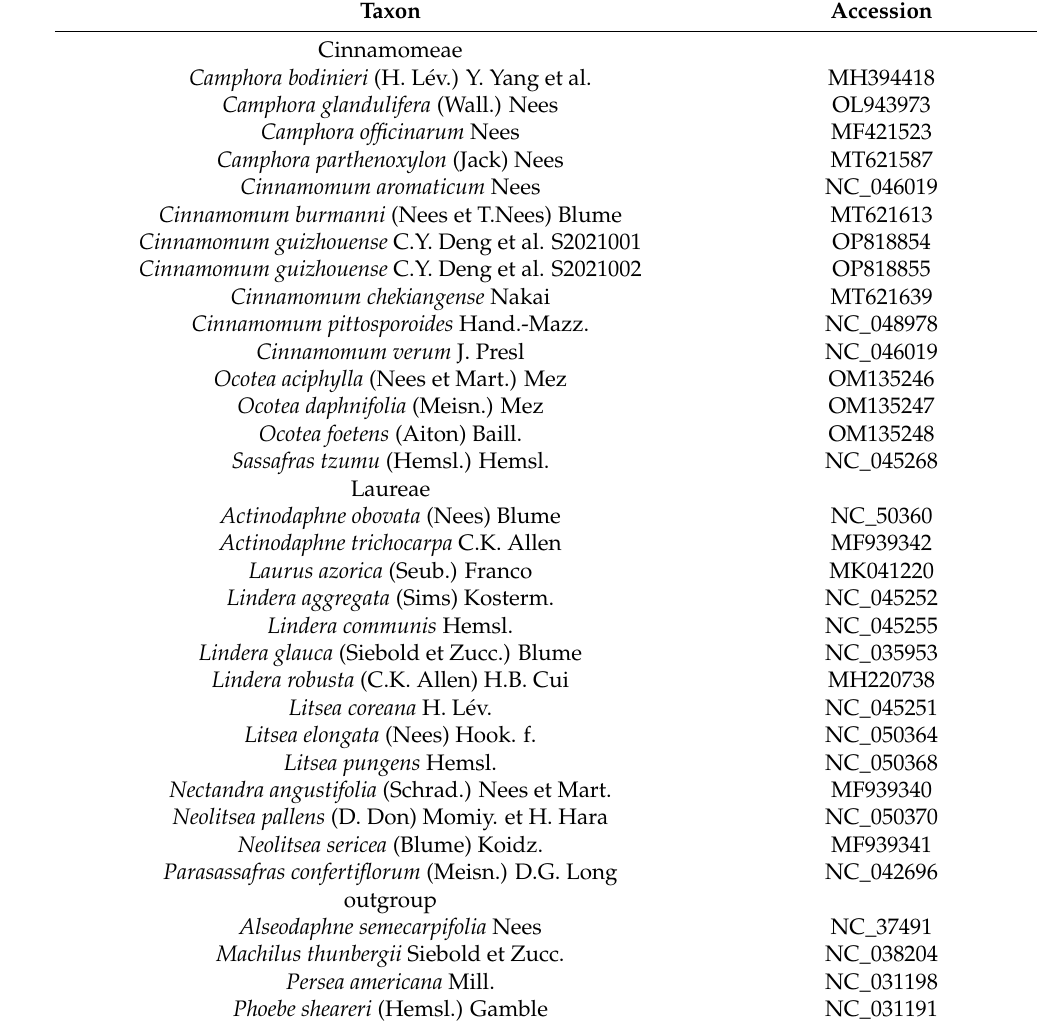
Table 2. Sequences obtained from